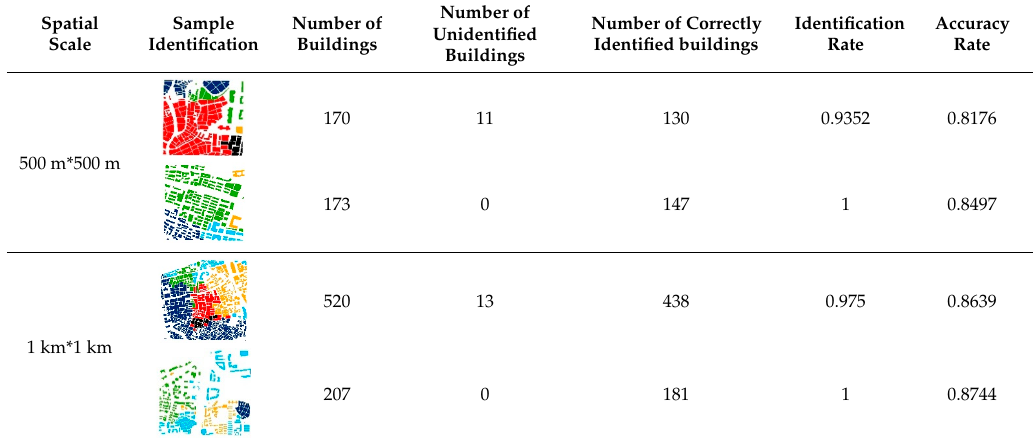
Table 2. The accuracy rate of identifying buildings at different spatial scales from the proposed scheme.